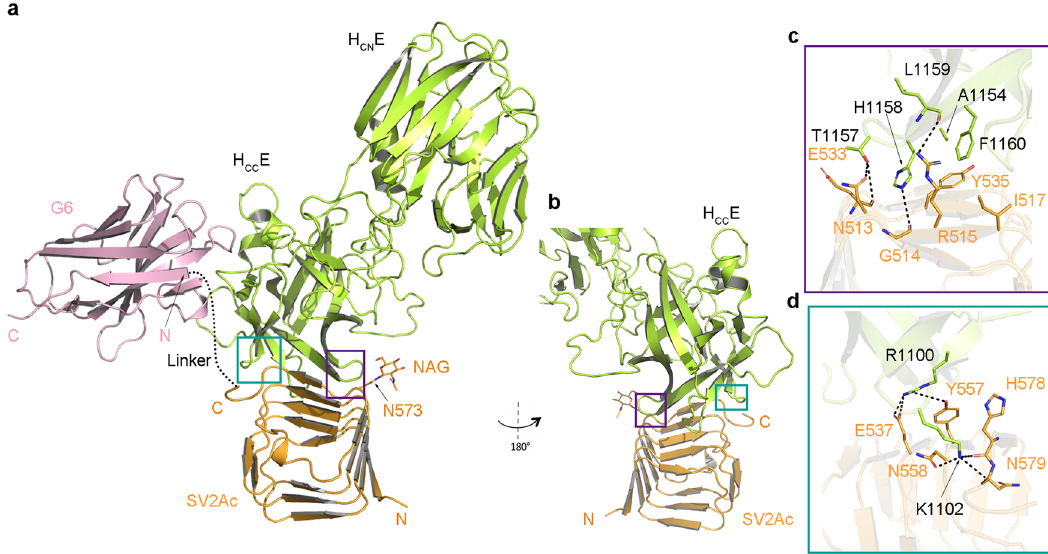
Fig. 3 | Overall structure of the H C E – SV2Ac – G6 complex. a Cartoon repre- sentation of the H C E – SV2Ac – G6 complex (H C E, lemon; SV2Ac, orange; G6, pink). H C E engages the protein moiety of SV2Ac mainly through two loops on its H CC E domain (teal and purple boxed areas). The dotted line indicates the fl exible linker